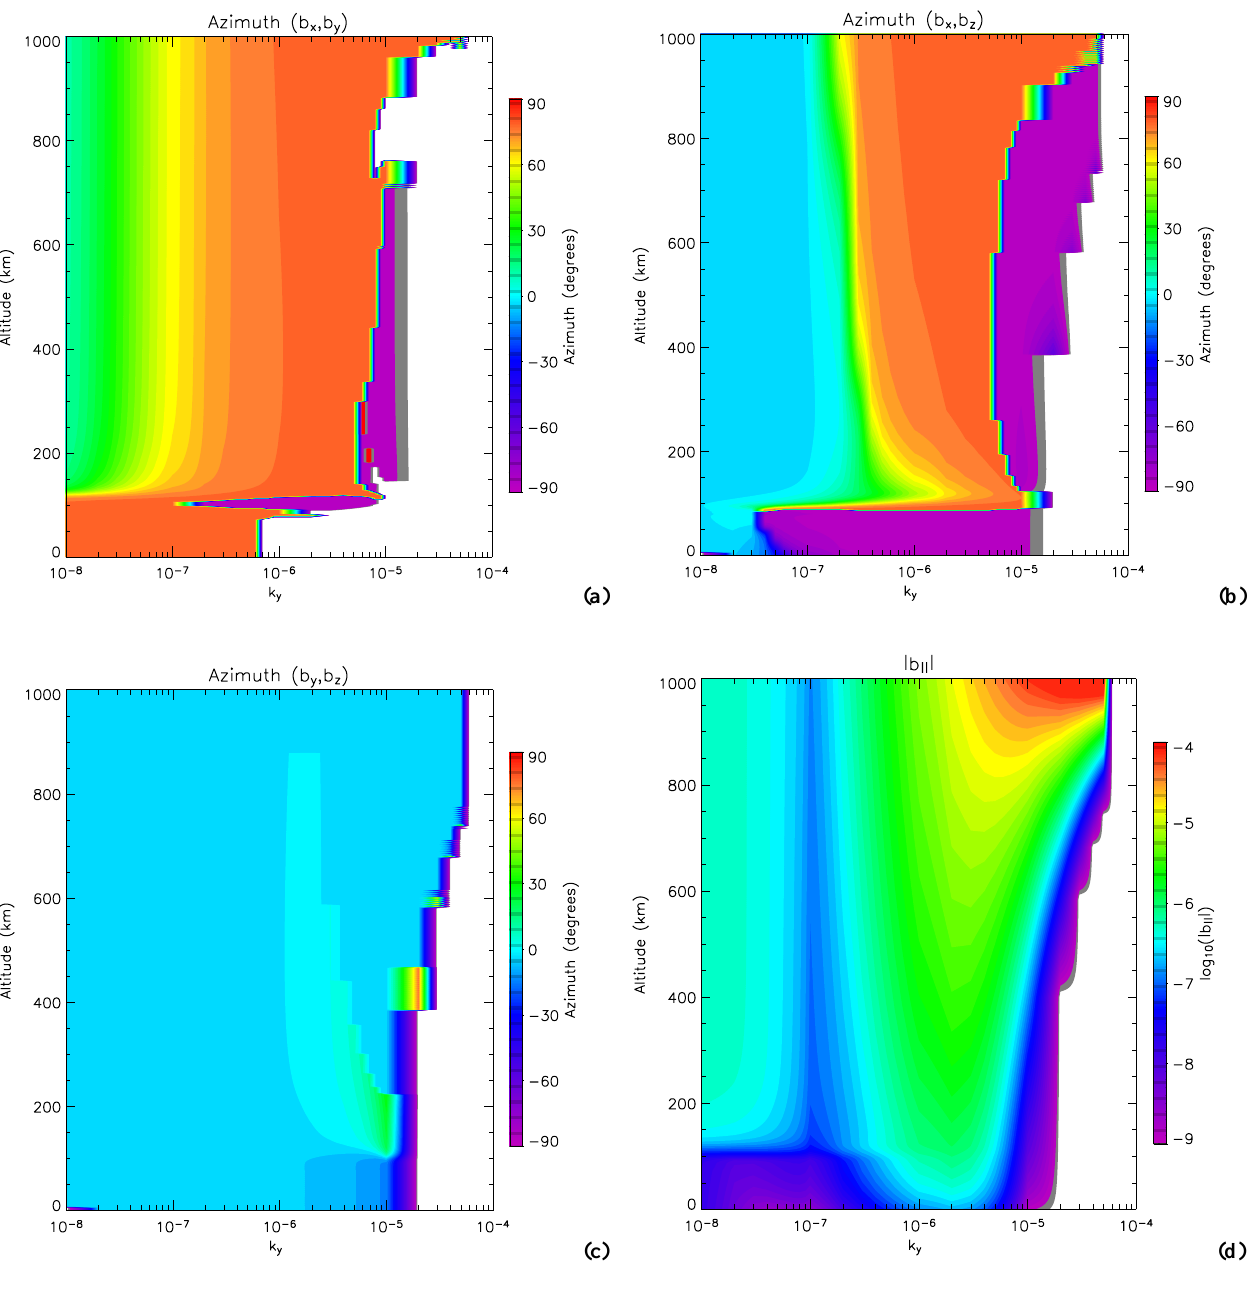
Fig. 11. Polarisation azimuths for an incident compresional (fast) mode. The ULF frequency was 16mHz, the dip angle, I = 70 ◦ and solar maximum conditions. Wavenumbers are k x = 10 − 10 m − 1 and k y varying between 10 − 8 m − 1 and 10 − 4 m − 1 . (a) Polarisation azimuth for b x and b y , (b) polarisation azimuth for b x and b z and (c) polarisation azimuth for b y and b z , (d) the amplitude of the field aligned (compressional) component of the ULF wave magnetic